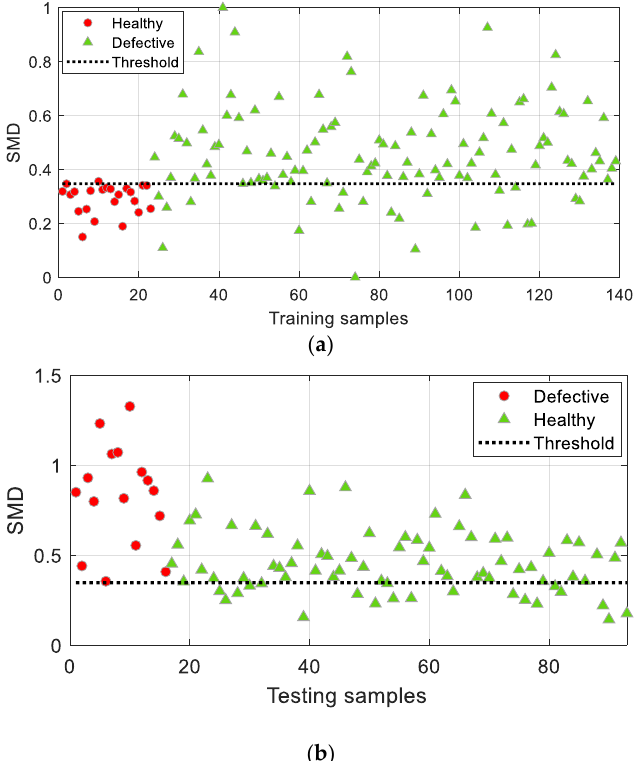
Figure 7. ( a ) Classification on the training dataset; ( b ) classification on the testing dataset.